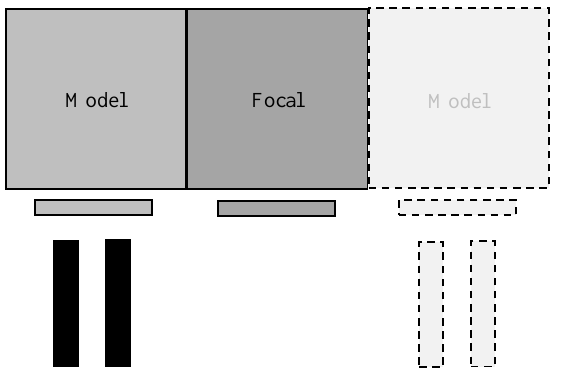
Figure 1 . Top view of the testing area and experimental set-up. The model could choose between two different objects, each one placed on an identical black tray. The focal individual could watch their choice from a small test chamber adjacent to the subject before being presented with the same choice. Depending on the location of each individual, the presentation of the objects to the model occurred either on the right or left side of the